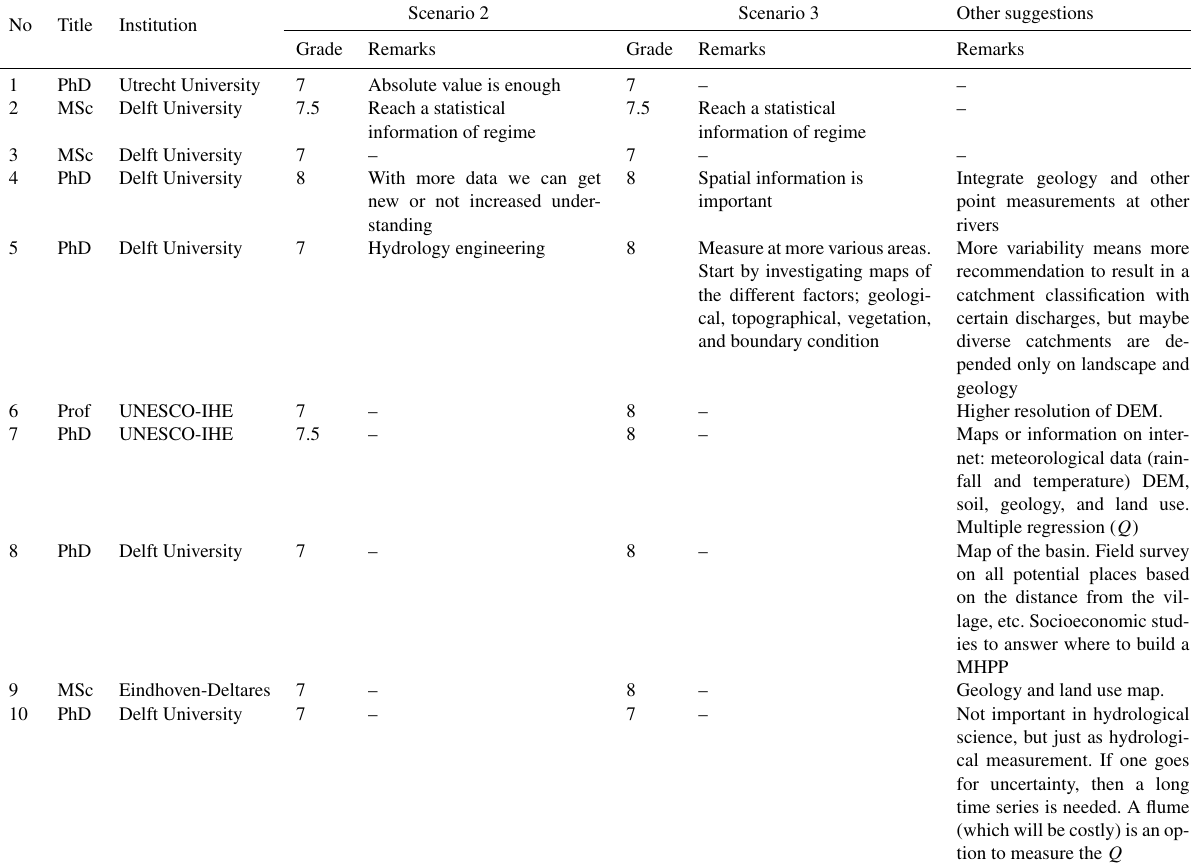
Table B3. Indonesia case: the experts’